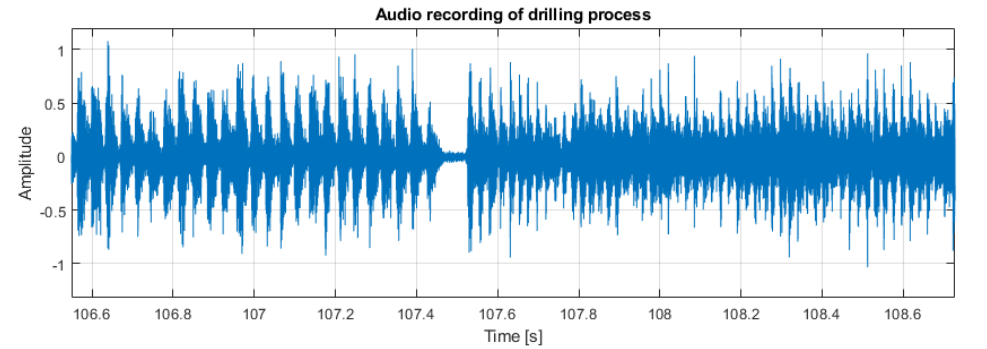
Figure 12. A closer look at the acoustic signal at the moment when pre-boring ended and proper drilling began. Visible portions of energy indicate individual percussion strokes. A difference in the percussion frequency between pre-boring (the left part of the signal) and proper drilling (the right side) is clearly observable.